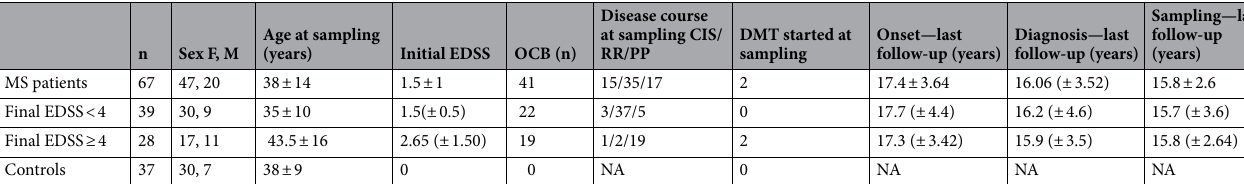
Table 1 outlines relevant demographic and baseline clinical data on the 67 patients and 37 controls.